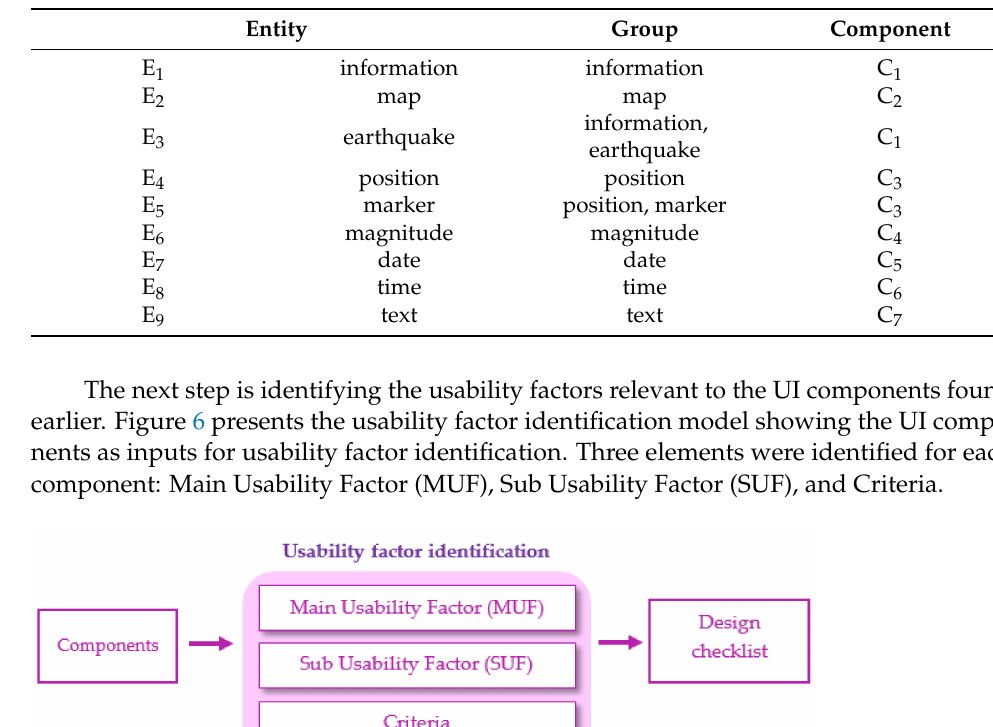
Table 5. The UI components identified from the list of information entities.